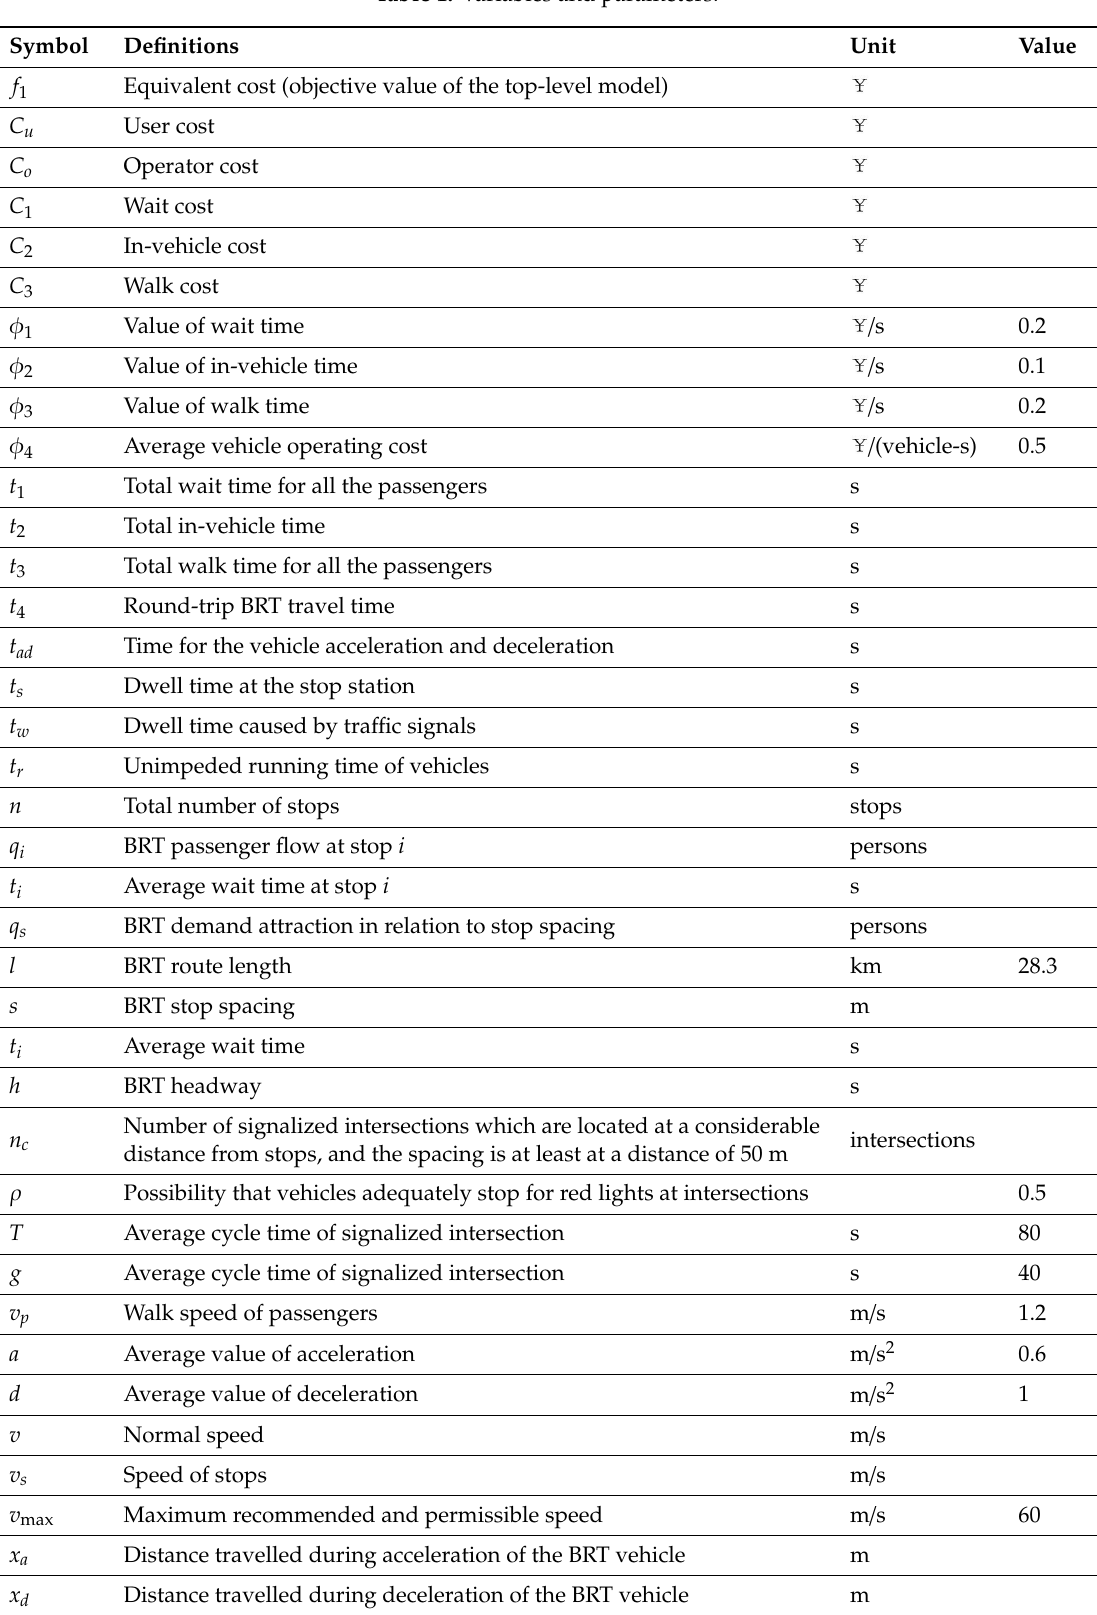
Table 1. Variables and